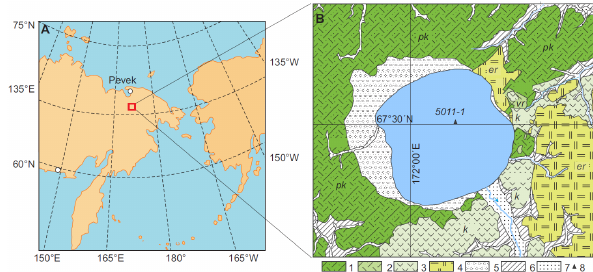
Figure 1 2 Fig. 1. (A) Location of Lake El’gygytgyn in easternmost Rus- sia. (B) Simplified bedrock geologic map of the Lake El’gygytgyn adapted from Bely and Raikevich (1994); Bely and Belaya (1998). Formation: 1 – Pykarvaam (pk); 2 – Voronian (vr); 3 – Koekvun’ (k); 4 – Ergyvaam (er); 5 – deluvian; 6 – terrace deposits; 7 – flood plain deposits; 8 – core